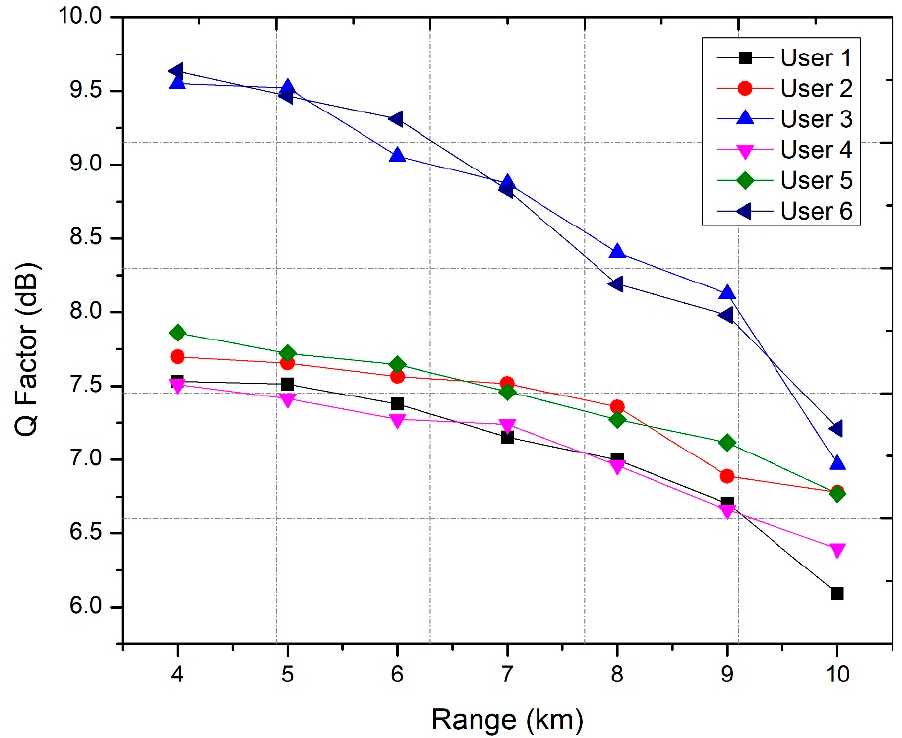
Figure 4. Q-factor for PDM-SAC-OCDMA-enabled FSO transmission under CW versus range.